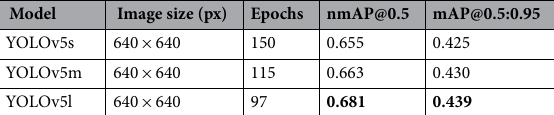
Table 1. The performance of the small, medium and large YOLOv5 model on the plate waste dataset.